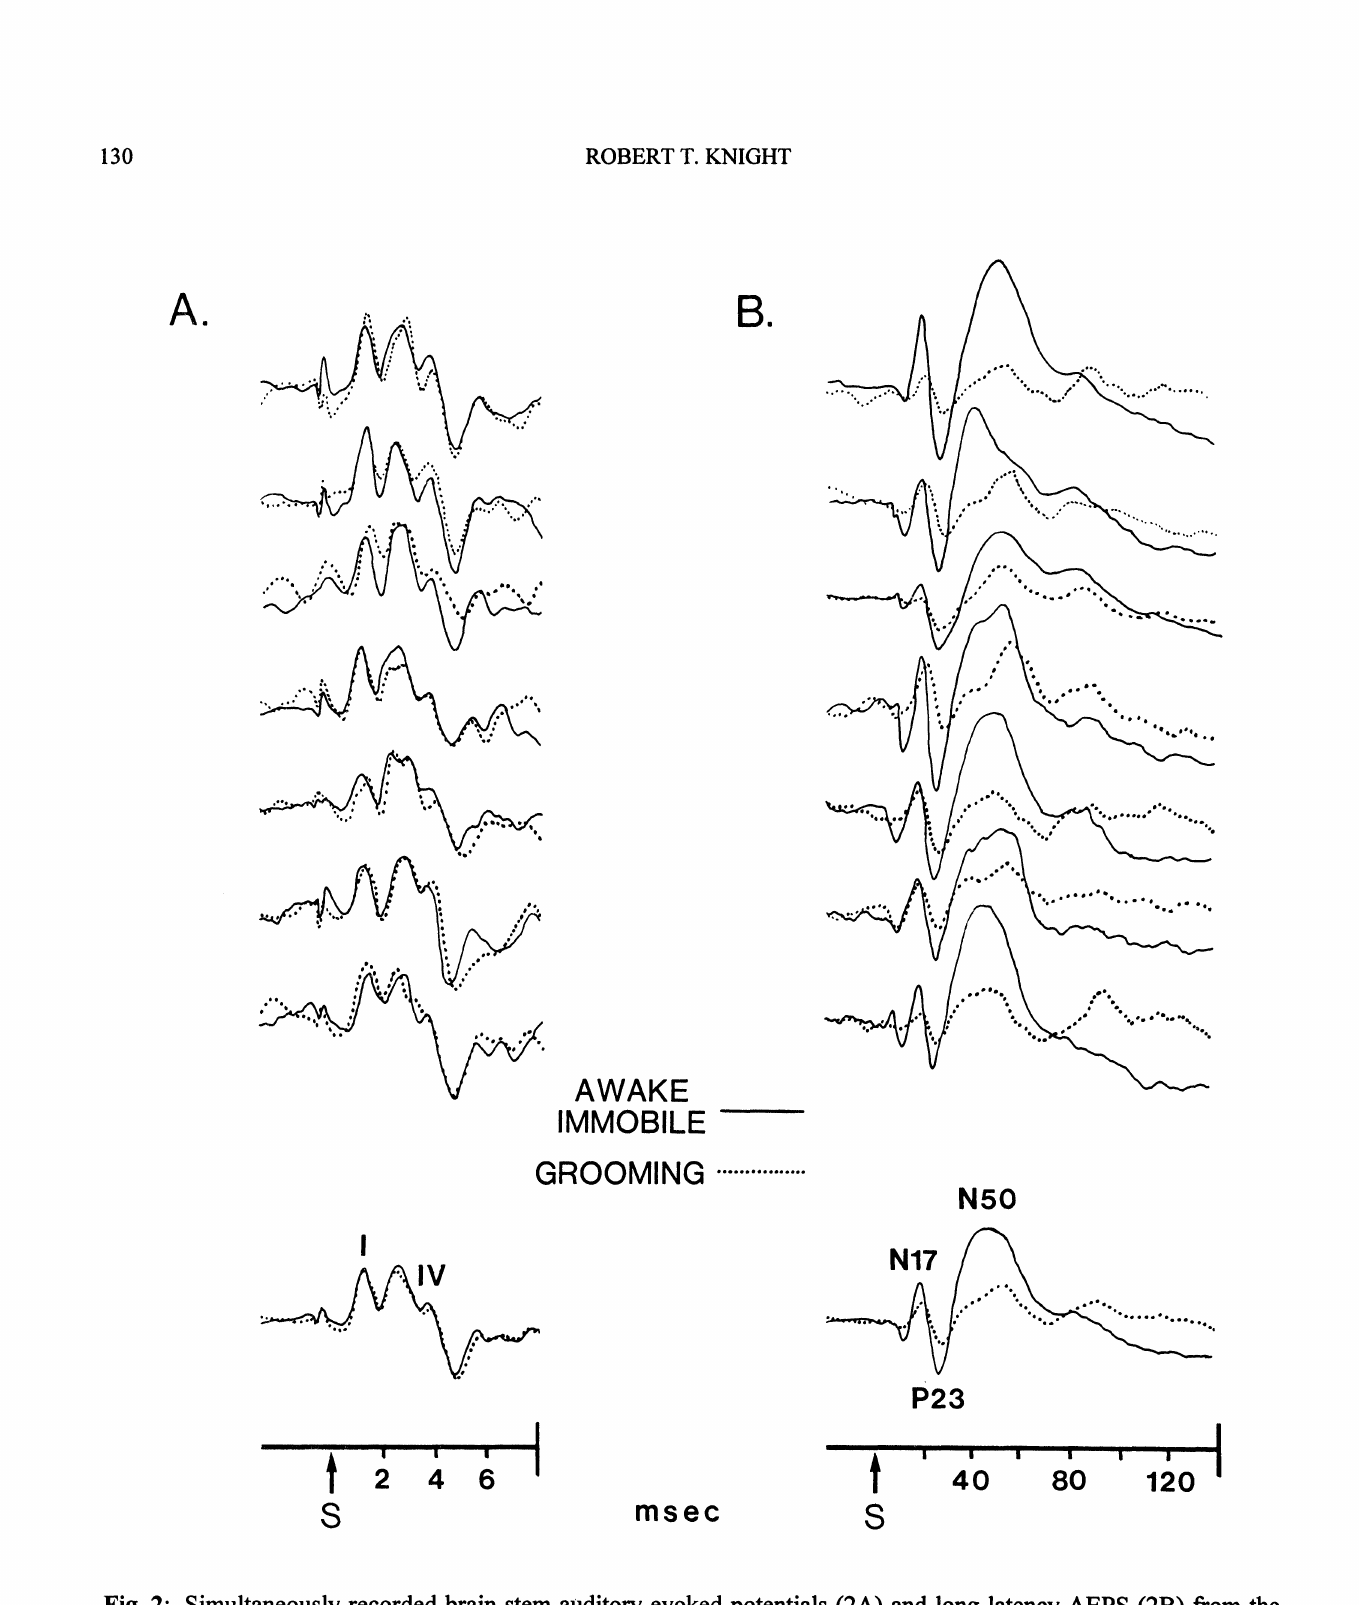
Fig. 2: Simultaneously recorded brain stem auditory evoked potentials (2A) and long latency AEPS (2B) from the rat in the awake state and while grooming. Grooming was def’med behaviorally and was associated with prominent theta in the EEG power spectrum. Data from seven animals are shown. The grand average for the group is shown on the bottom. Wave I represents auditory nerve activity and wave IV arises in the inferior colliculus. There is no difference in the BAEPS for the two behavioral states providing a control for peripheral sensory factors. Grooming has prominent effects on long latency hippocampal dependent AEPs with effects onsetting by 15-20 milliseconds post-stimulation. The results provide evidence of early state dependent gating of sensory flow (unpublished